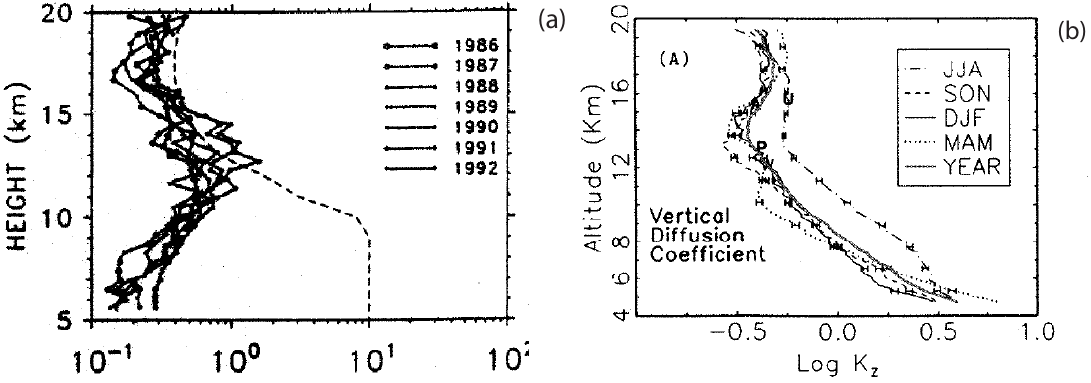
Fig. 6. (a) : Annual median of K θ inferred from the MU radar observations from 1986 to 1992 (Kurosaki et al., 1996). The dotted curve shows the diffusivity profile from Massie and Hunten (1981). (b) : Seasonal medians of log K θ from the WSMR radar observations (Nastrom and Eaton,